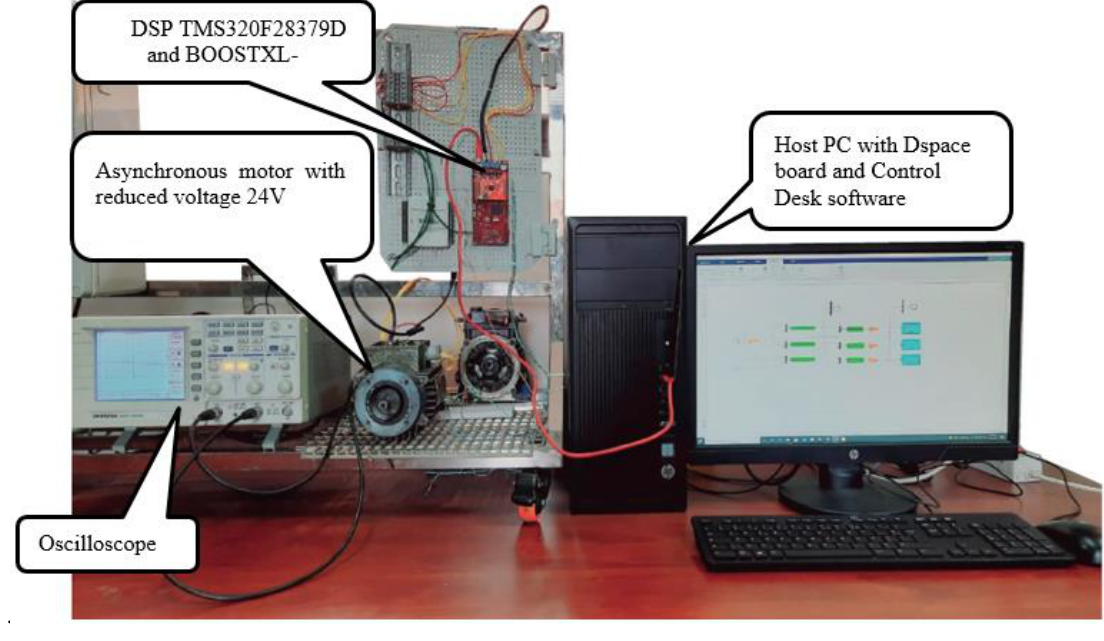
Figure 13. Photo of the traction chain test bench